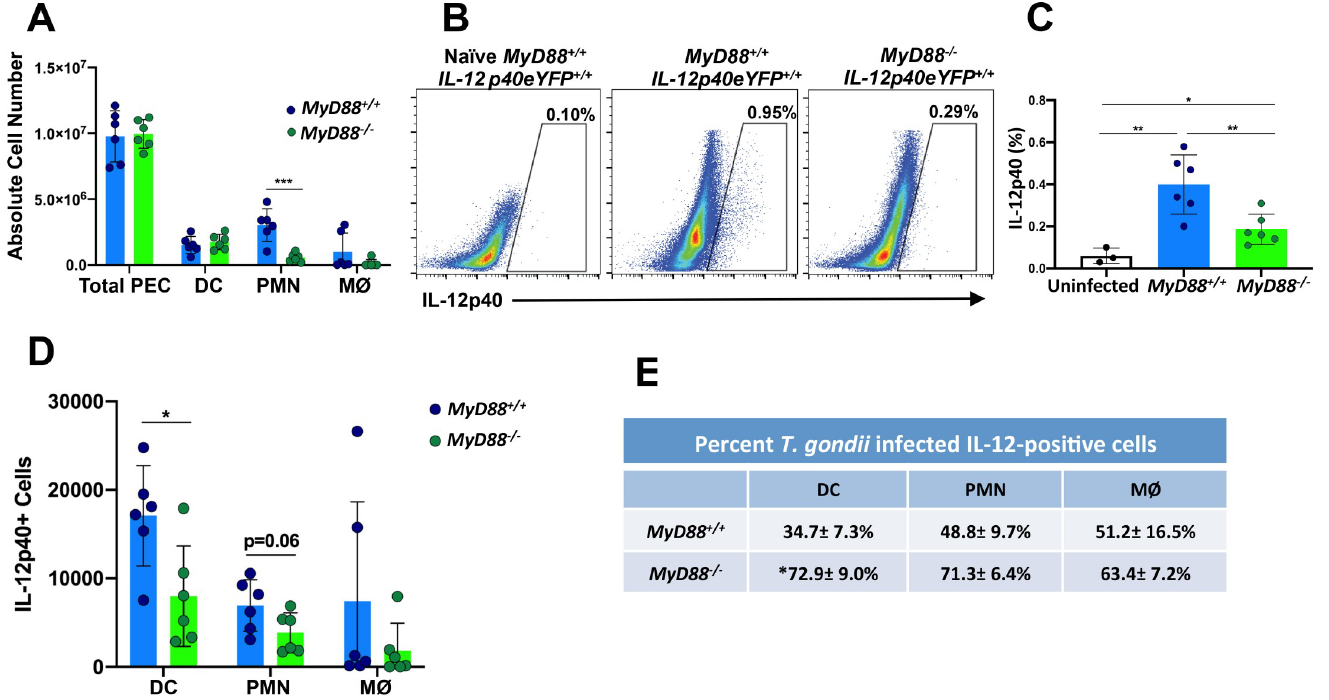
Fig 2. Multiple cell types produce MyD88-independent IL-12 during in vivo infection. IL-12 reporter mice on a wild type ( MyD88 +/+ IL-12p40 eYFP/eYFP ) and MyD88 knockout ( MyD88 -/- IL-12p40 eYFP/eYFP ) background were infected by intraperitoneal injection with 10 3 RH strain tachyzoites. On day 5 post-inoculation, peritoneal exudate cells were collected for ex vivo analysis. ( A ) Number of PEC, dendritic cells (DC), neutrophils (PMN) and macrophages (M Ø ) present in the peritoneal cavity. ( B ) Percentage of IL-12eYFP positive cells in the peritoneal cavity of one representative infected MyD88 +/+ IL-12p40 eYFP/eYFP , one representative infected MyD88 -/- IL-12p40 eYFP/ eYFP , and one representative noninfected MyD88 +/+ IL-12p40 eYFP/eYFP mouse. ( C ) Percent IL-12 positive cells in the peritoneal cavities of WT and MyD88 KO IL-12 reporter mice. ( D ) Number of IL-12 positive cells amongst DC, PMN and M Ø isolated from MyD88 +/+ and MyD88 -/- reporter mice. ( E ) Percent of infected cells that are positive for IL-12. In these experiments, DC were defined as MHCII + , CD11c + , F4/80 - cells; PMN were defined as Ly6G + cells; M Ø were defined as F4/80 + cells. Values are the means ± SEM of 2 pooled independent experiments, n = 6 per group. Each symbol represents an individual mouse. Statistical significance was assessed using Student’s t test ( � p < 0.05, �� p < 0.01, ��� p < 0.001) ( A , C and D ). Mann-Whitney test was used to determine statistical significance of IL-12-positive MyD88 WT vs. KO DC in E . These experiments were performed three times with similar